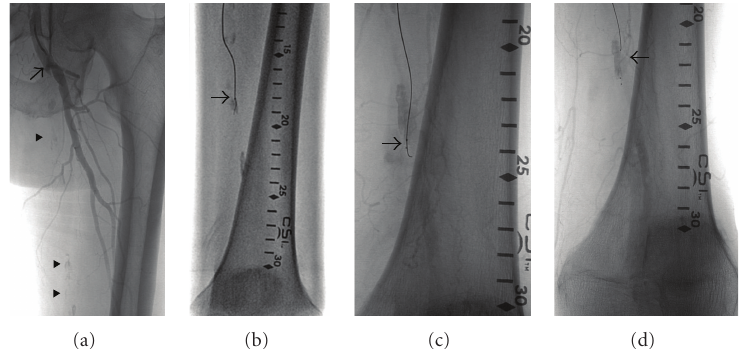
Figure 3: Unsuccessful use of the CrossBoss and Stingray catheter. (a) Angiography showing occlusion of the left superficial femoral artery (SFA) at its ostium (arrow). The course of the occluded vessel is outlined by areas of calcification (arrowheads). (b) Wire inside the CrossBoss catheter (arrow) crossing an occluded, calcified segment. (c) Wire advanced through the StingRay balloon catheter (arrow) trying to gain entry into the true lumen of the distal SFA. (d) Wire back into the StingRay balloon catheter with final angiography showing retrograde filling of the distal SFA and some contrast extravasation